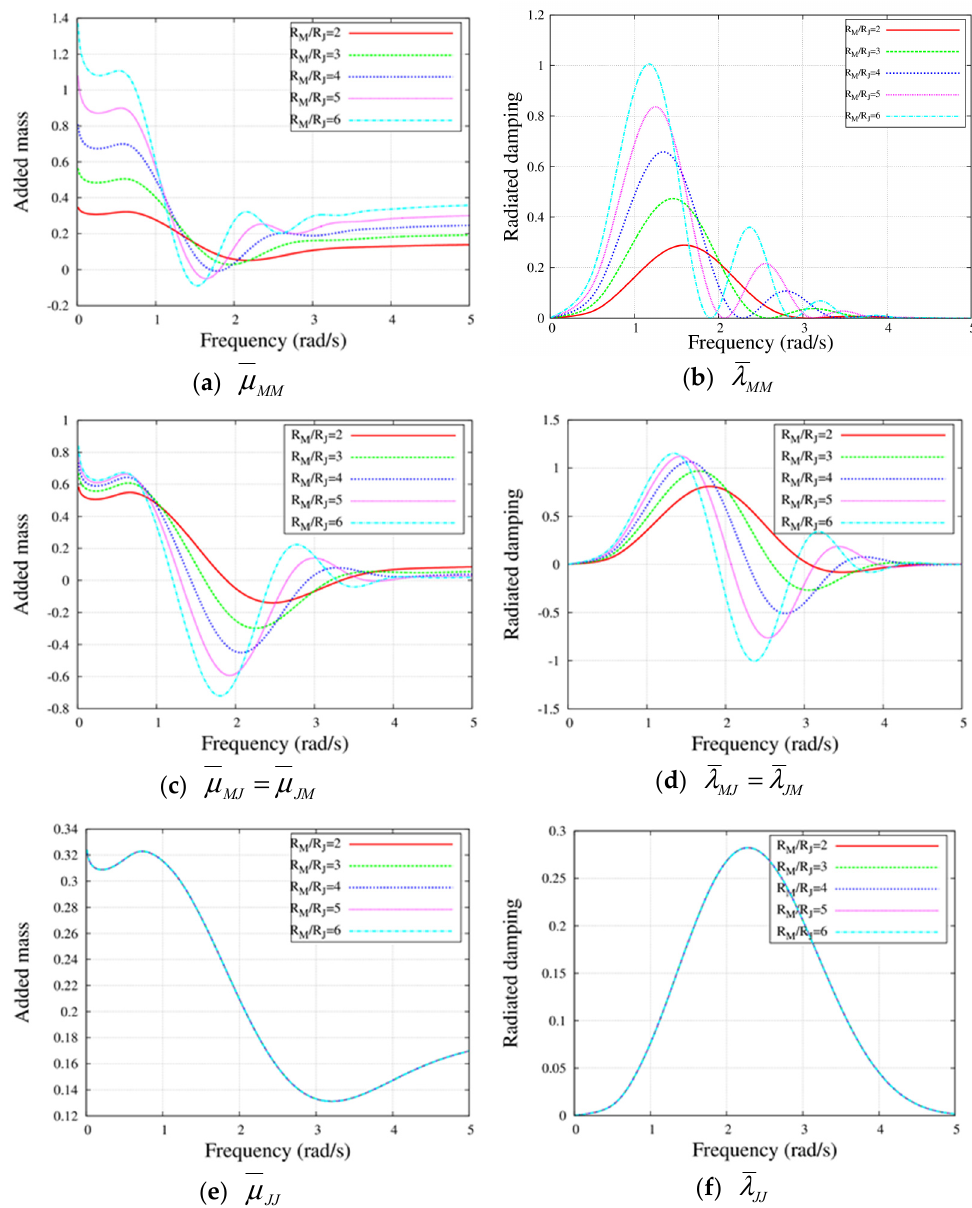
Figure 7. The hydrodynamic coefficients of the moonpool platform and the sea javelin.